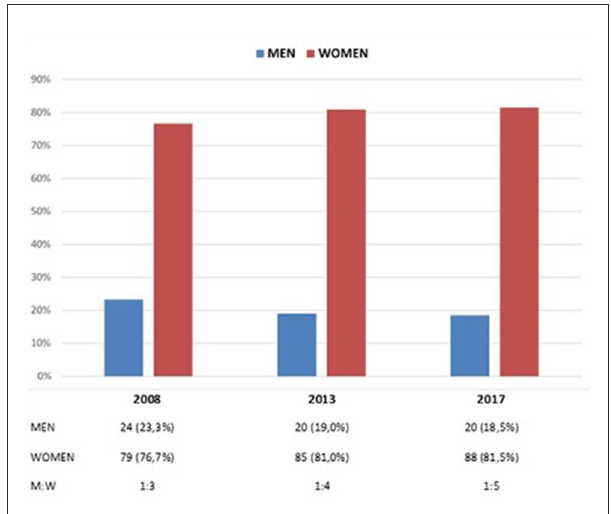
FIGURE1 Men/women editors in 2008, 2013, and 2017